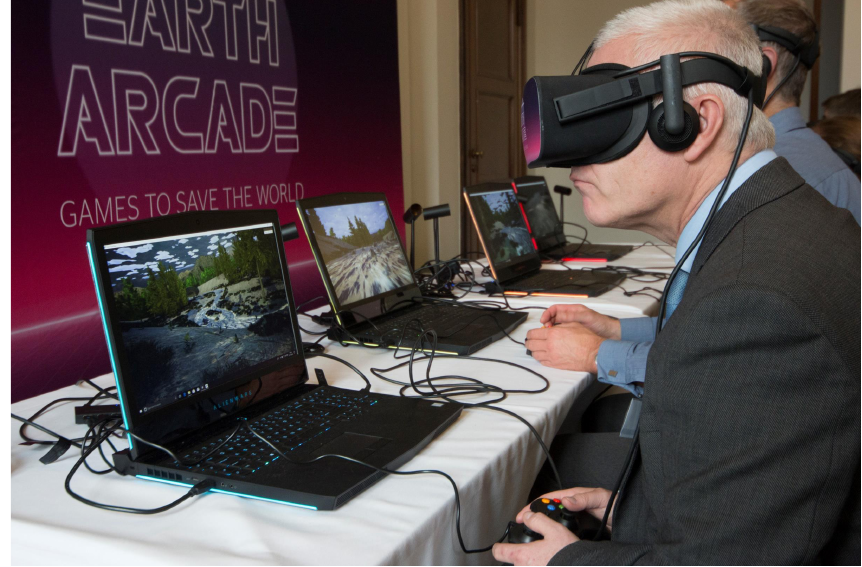
Figure 4. Flash Flood! being demonstrated at the FFIR Showcase at the Royal Society in November